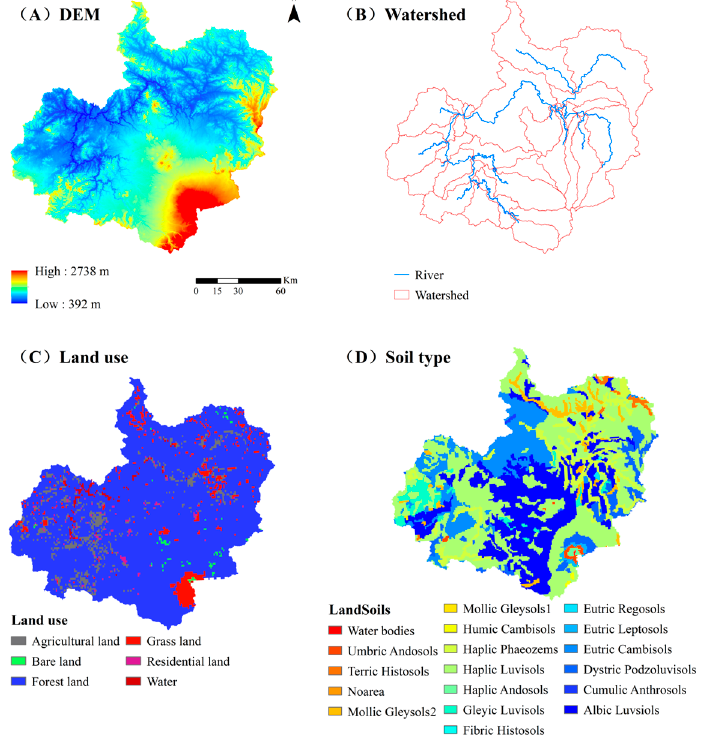
Figure 6. SWAT model setup: ( A ) DEM, ( B ) watershed, ( C ) land use, ( D ) soil type.